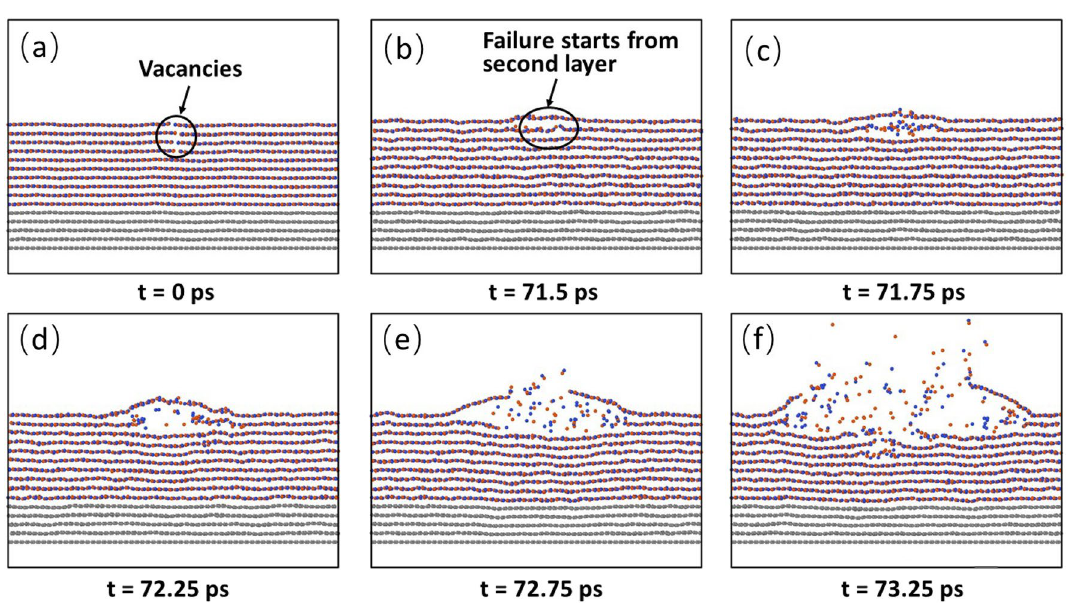
Figure 8. Failure process of the sample with 10 h-BN layers with first to fourth layer each containing a B vacancy. The failure starts from the defect site at the second layer and propagate horizontally and vertically, causing the formation of a